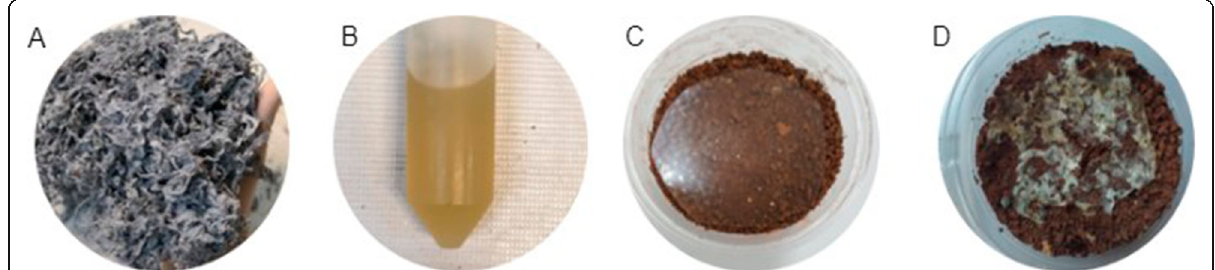
Fig. 4 Biodegradable films for application in agriculture from tannery solid waste, a (trimming leather waste), b (recovered gelatin), c - d (simulated soil application test: time 0 and 60 days,